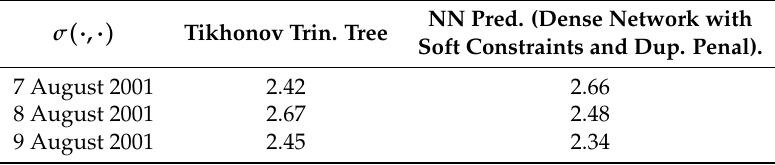
Table 8. Training set RMSEs of Tikhonov trinomial tree vs. NN predicted prices against market prices. NN Pred. (Dense Network with σ ( · , · ) Tikhonov Trin. Tree Soft Constraints and Dup.